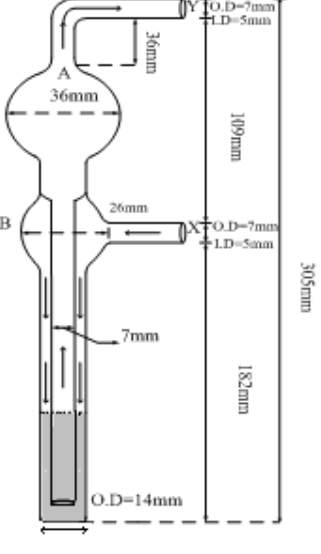
Figure 1. Diagram of the concentric tube bulb